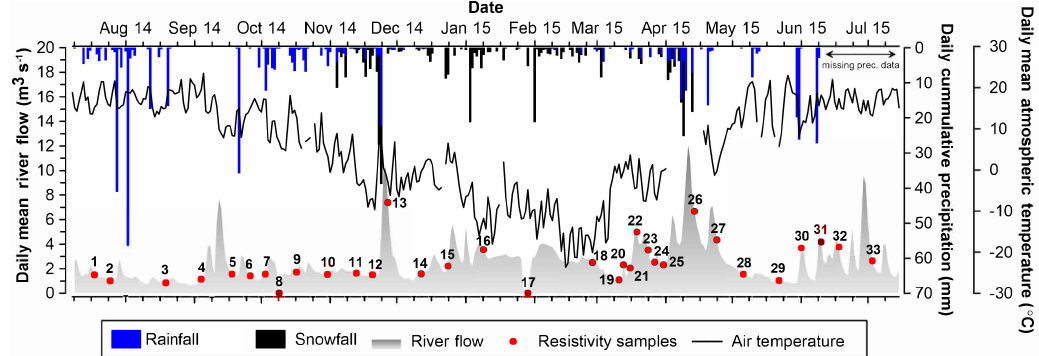
Figure 4. Continuously monitored atmospheric conditions and river flow from Watson Gauge during the study period, with superimposed resistivity geophysical measurement events between 18 July 2014 and 3 July 2015. Note: snowfall is presented as snow water